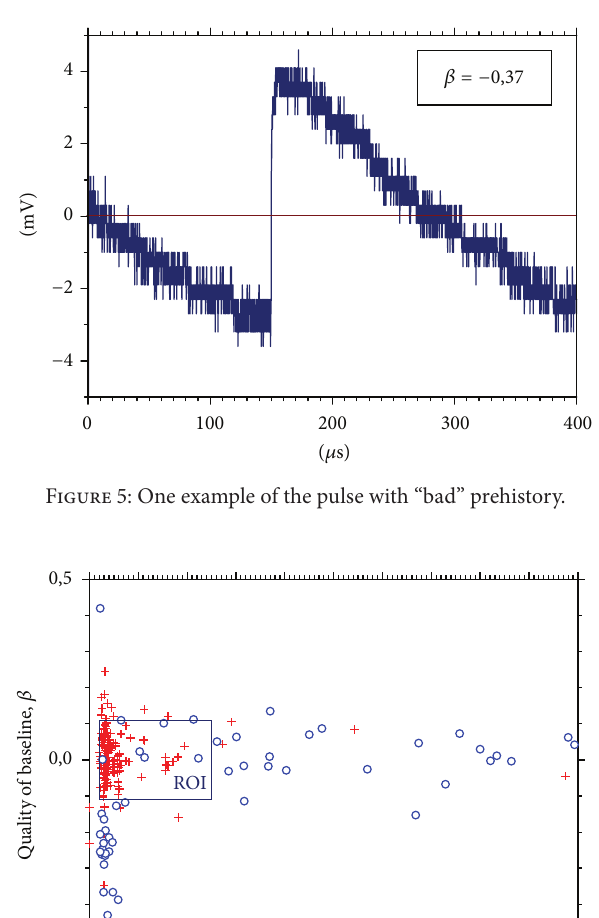
rejected as “noisy” pulses. One of the typical “noise” pulses is presented in Figure 5.